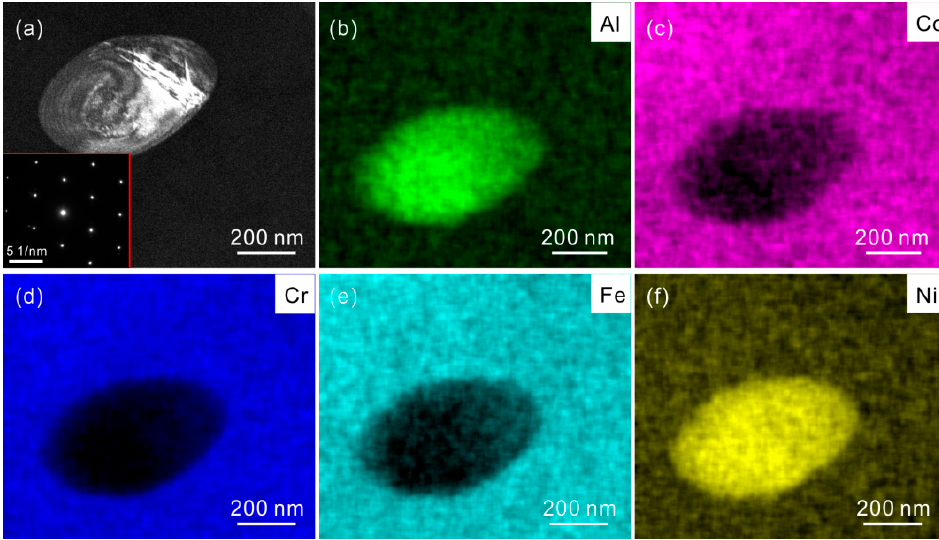
Figure 4. TEM-EDS elemental mapping for precipitate phase. ( a ) TEM image of precipitate and the inset is corresponding selected area electron diffraction (SAED) pattern; ( b ) Al, ( c ) Co, ( d ) Cr, ( e ) Fe and ( f ) Ni.